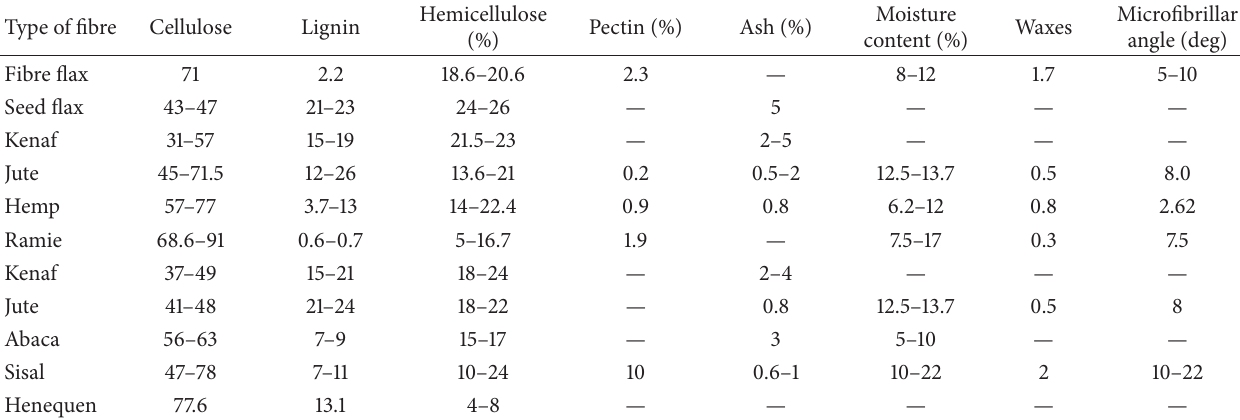
Table 2: Chemical composition of natural fibres [41, 44].